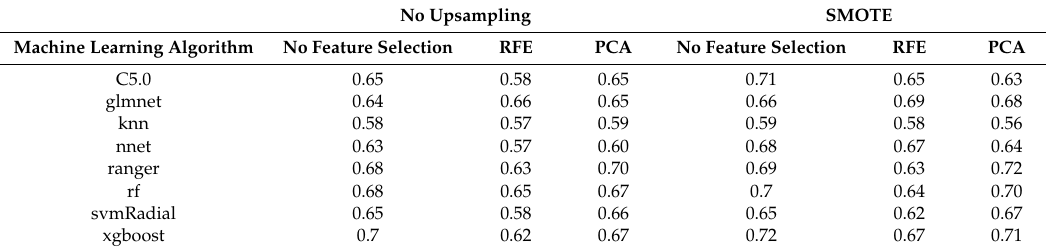
Table 3. Area under the receiver-operating characteristics (ROC) curve (AUC) for the combinations of various machine learning models, feature selection, and imbalance handling. No Upsampling SMOTE Machine Learning Algorithm No Feature Selection